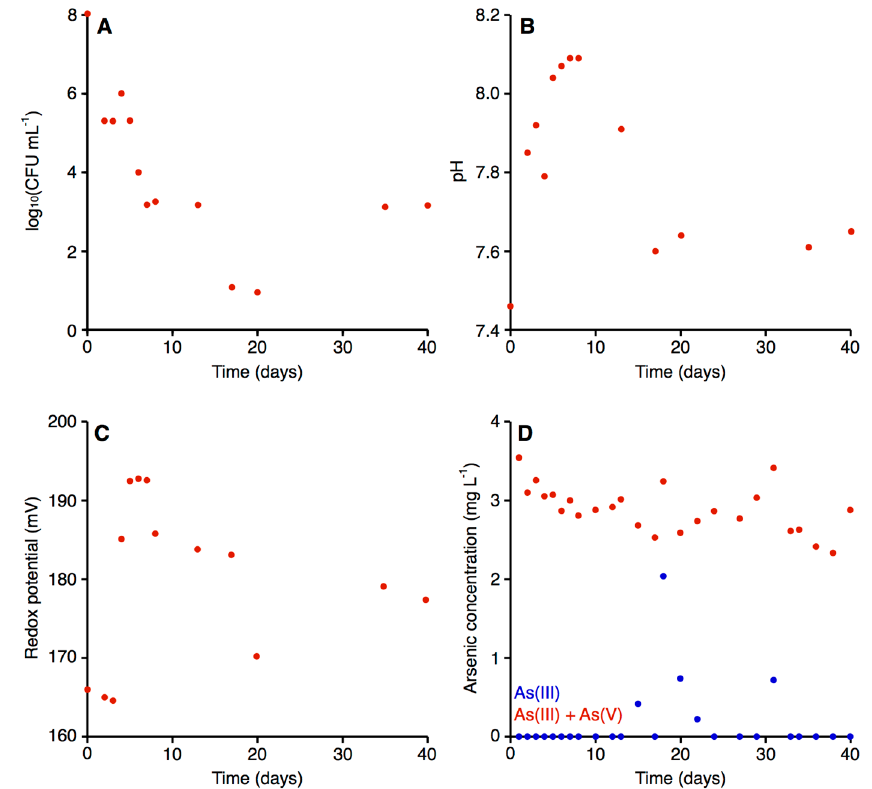
Figure 4. Parameters of the water in the bioreactor of the microbiological module. The graphs display ( A ) the quantity of bacteria, ( B ) the pH of the water, ( C ) the redox potential of the water, and ( D ) the concentration of As(III) (blue) and total arsenic (red) in the water.